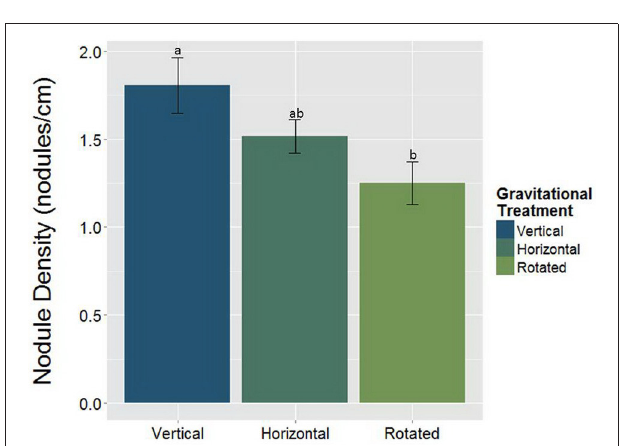
FIGURE 8 | The main effect of gravitational treatments on nodule density (nodules/cm) in M. truncatula ( n = 71 ). Nodule density was calculated to compensate for the differences in total root length among gravitational treatments. The number of nodules per centimeter of root is significantly reduced in nodulated, clinorotated ( n = 30 ) groups compared to the nodulated, vertical controls ( p < 0.05 ; n = 19 ). The letters above each standard error bar denote significance between gravity treatments.